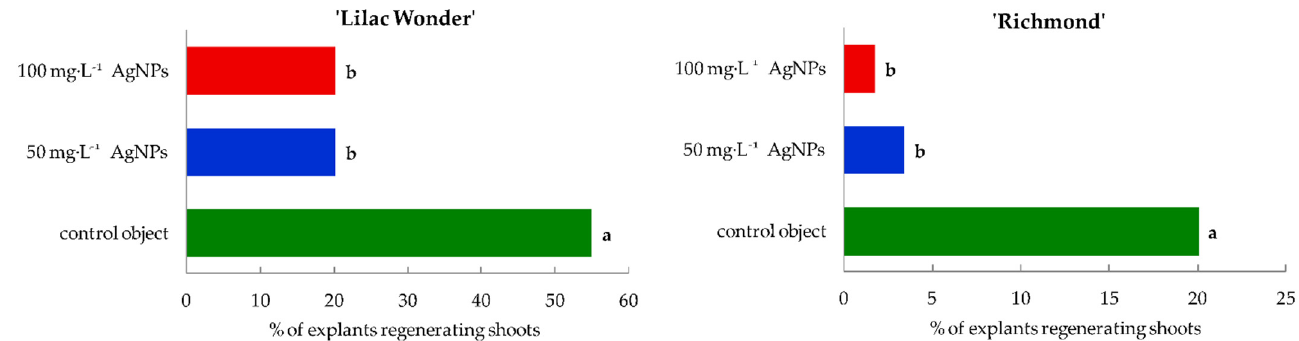
Figure 2. Shoot induction rate of Chrysanthemum × grandiflorum ‘Lilac Wonder’ and ‘Richmond’ leaf explants after 10 weeks of culture on the modified MS medium with 0.6 mg·L − 1 BAP and 2 mg·L − 1 IAA, depending on the AgNPs treatment (0–100 mg·L − 1 ). Means on graphs for each cultivar tested followed by the same letter do not differ significantly at p ≤ 0.05 (Tukey’s test).